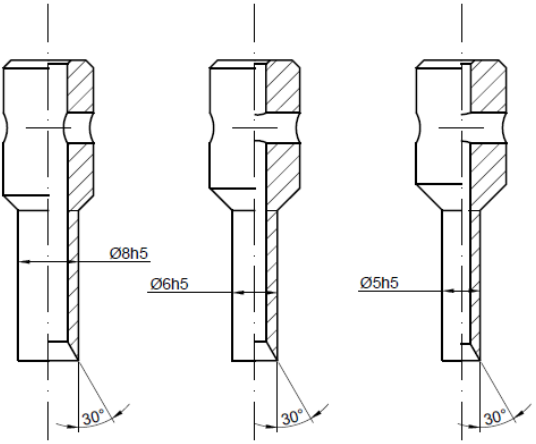
Figure 7. Second series of tested tools—piercing punches with the cutting edge pointing towards the inside with a variable diameter and constant angle of the blade.